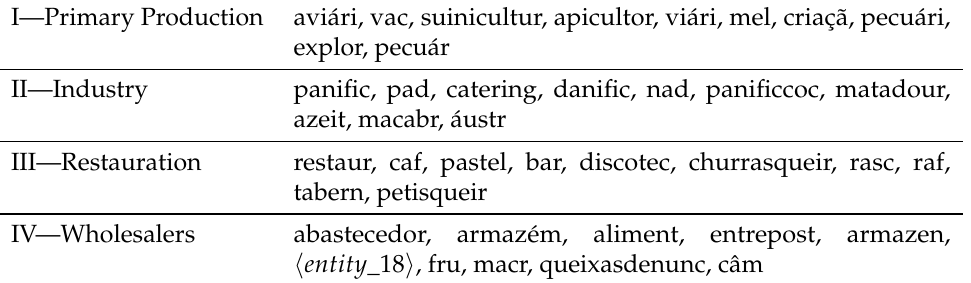
Table 18. Top-10 features for economic activity prediction using stemming with SVM.